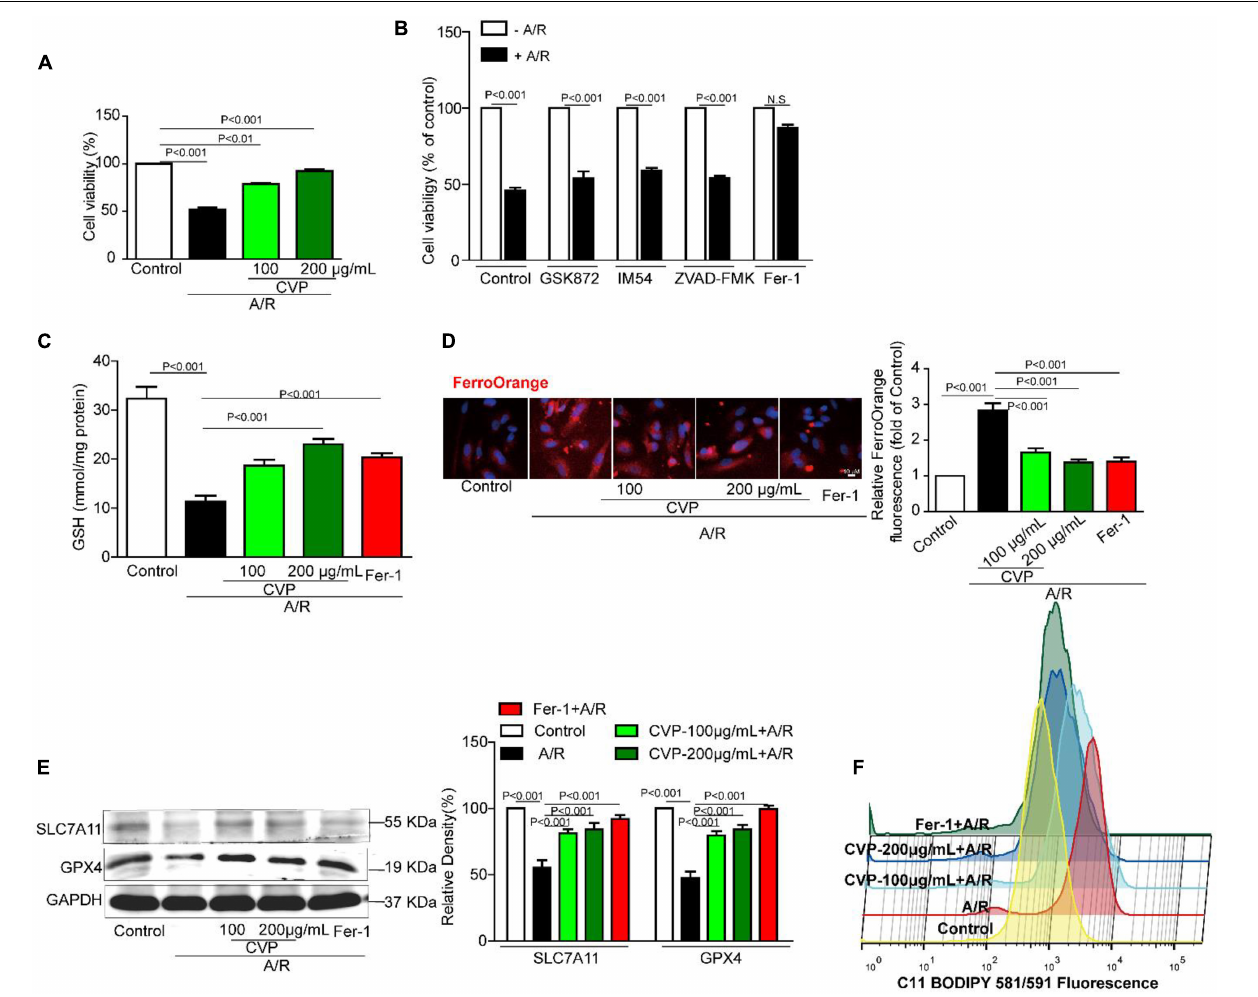
FIGURE 6 | The effect of CVP on A/R-stimulated cardiomyocytes and related mechanisms in vitro . Cardiomyocytes were pretreated with necroptosis inhibitor GSK872 (10 µ M), apoptosis inhibitor ZVAD-FMK (1 µ M), necrotic inhibitor IM54 (10 µ M), ferroptosis inhibitor Fer-1 (10 µ M), and CVP (200 µ g/ml) for 1 h and then stimulated with A/R, cell viability was tested with MTT assay (A,B) ; cellular GSH concentration was detected by GSH Detection Assay Kit (C) ; intracellular Fe 2 + was assessed with dye FerroOrange (D) ; SLC7A11 and GPX4 were detected by Western blotting (E) ; and fluorometric analysis of lipid ROS was carried out using C11-BODIPY dye (F) . A/R, anoxia/reoxygenation injury; CVP, Chuanminshen violaceumis polysaccharides; Fer-1,